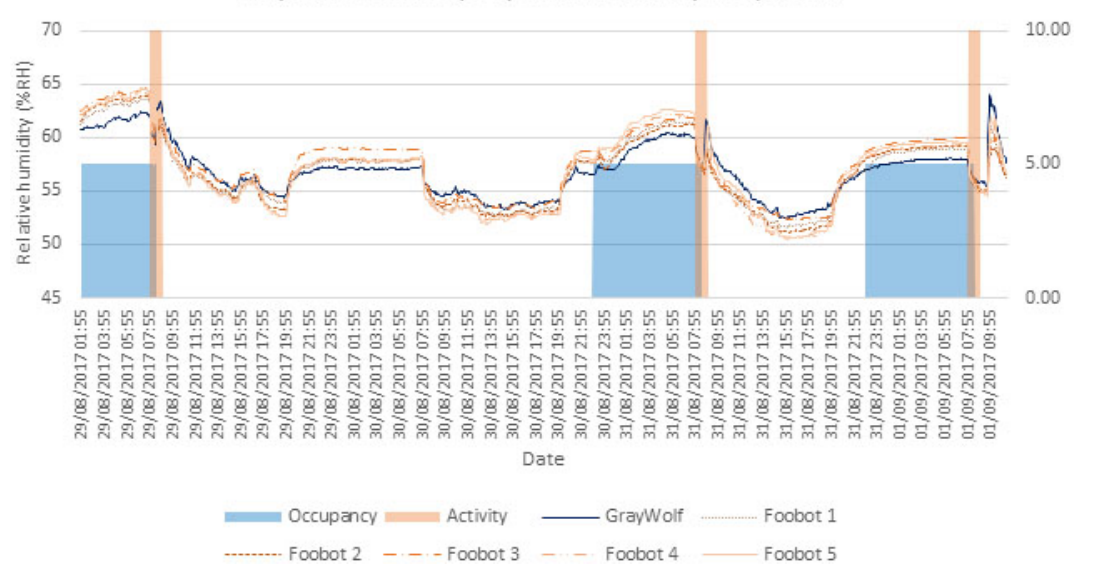
Figure 4. Relative humidity levels from 29 August to 1 September 2017 form the Foobot and GrayWolf instruments. (Activity describes the morning routine: showering, grooming, and